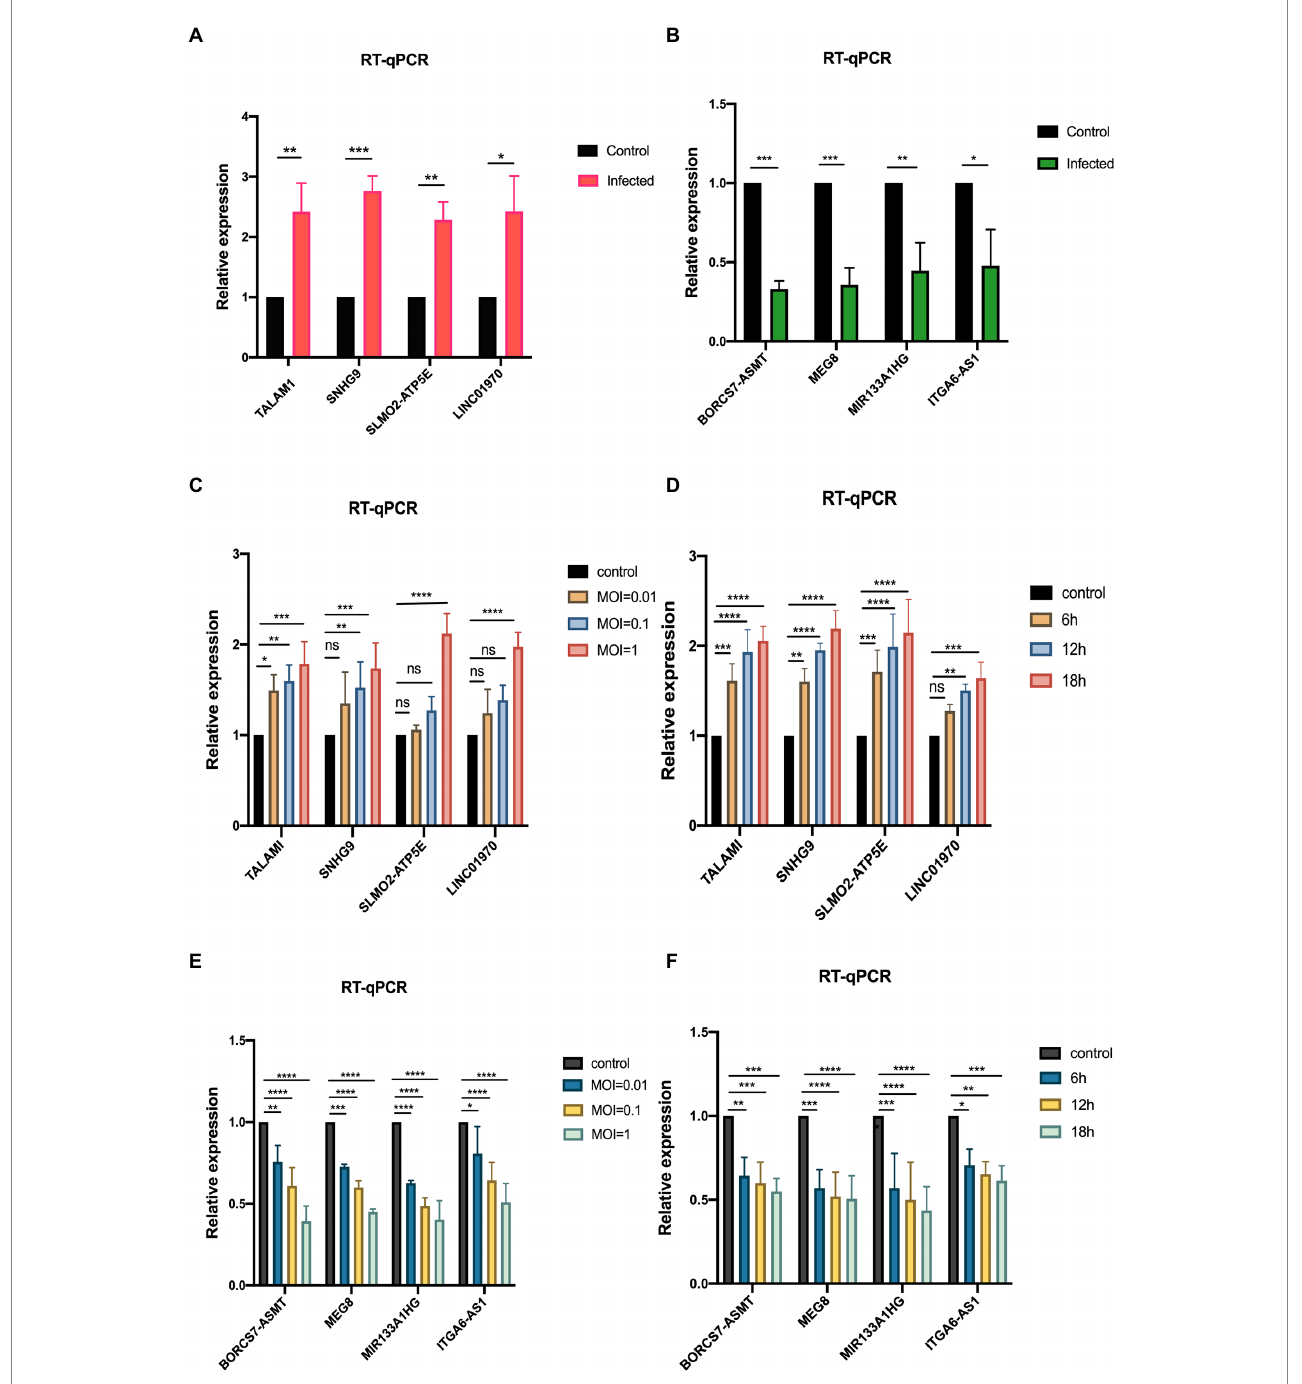
FIGURE 5 Validation of sequencing data by qRT-PCR (A,B) qRT-PCR validation of the screened up-and down-regulated genes, establishing the control group (MOI = 0) and the infected group (MOI = 1). (C,D) qRT-PCR was performed to verify the expression variations of up-regulated genes in RD cells after infection with EV-D68 at concentration gradients (MOI = 0.01, 0.1, 1) for 24 h and time gradients (6 h,12 h,18 h post-infection), MOI = 1. (E,F) qRT-PCR was used to verify the RNA levels of down-regulated genes at the concentration gradient and time gradient, respectively (* p < 0.05, ** p < 0.01, *** p < 0.001, **** p <